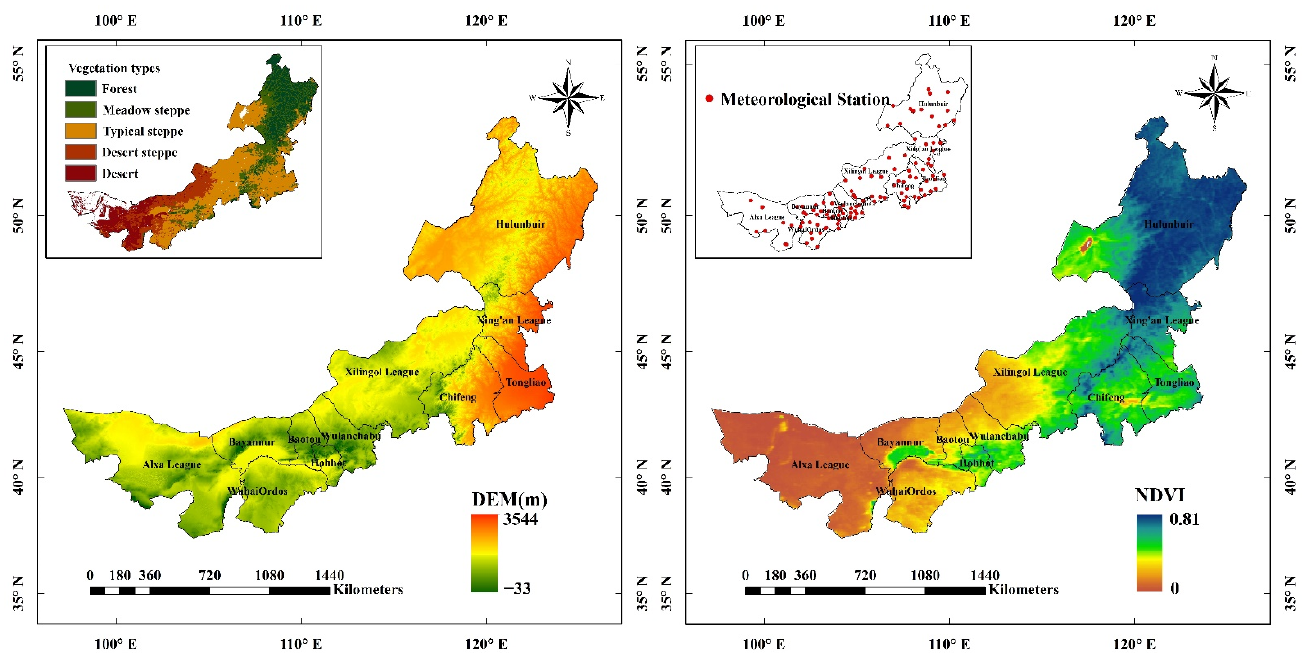
Figure 1. The distribution of elevation, NDVI, grassland vegetation types, and meteorological stations in Inner Mongolia.